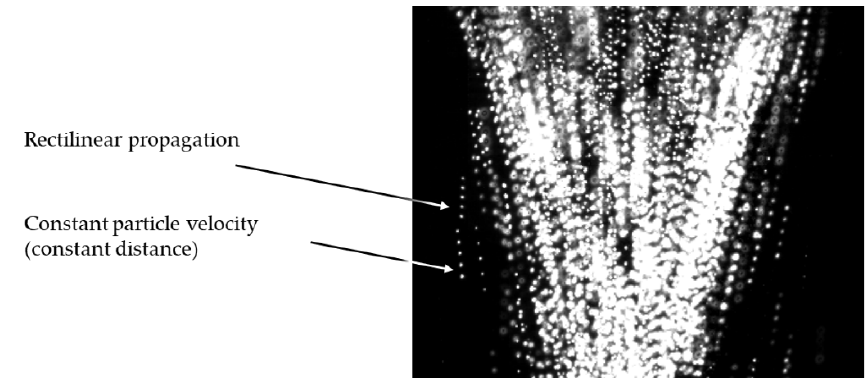
Figure 13. Images of the powder-gas jet taken at high speed with multiple exposures. Parameters: grain fraction − 53 + 20 µm, = 5 g/min, V FG = 5 L/min, V SG = 10 L/min [1]. Reprinted with permission from Ref [1]. Copyright 2020, Fraunhofer Verlag. 𝑚𝑚̇ 𝑝𝑝